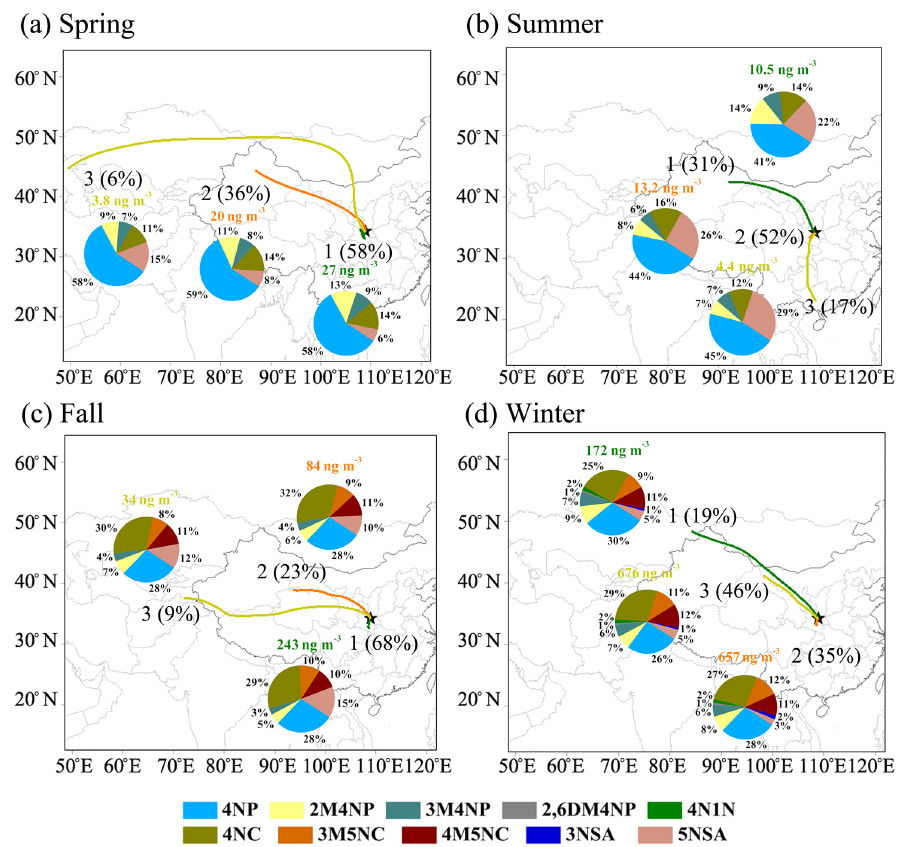
Figure 5. NACs at each 72h backward trajectory cluster during (a) spring, (b) summer, (c) fall, and (d) winter. The full names of the compounds are given in Table